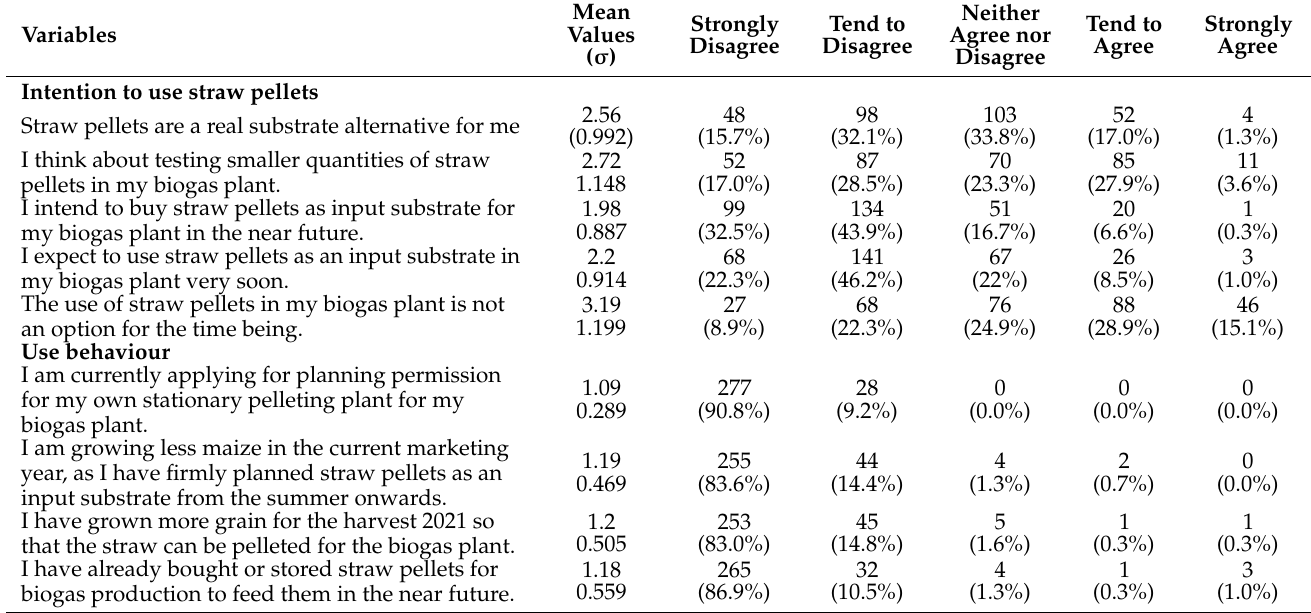
Table A1. Descriptive statistics corresponding to Table